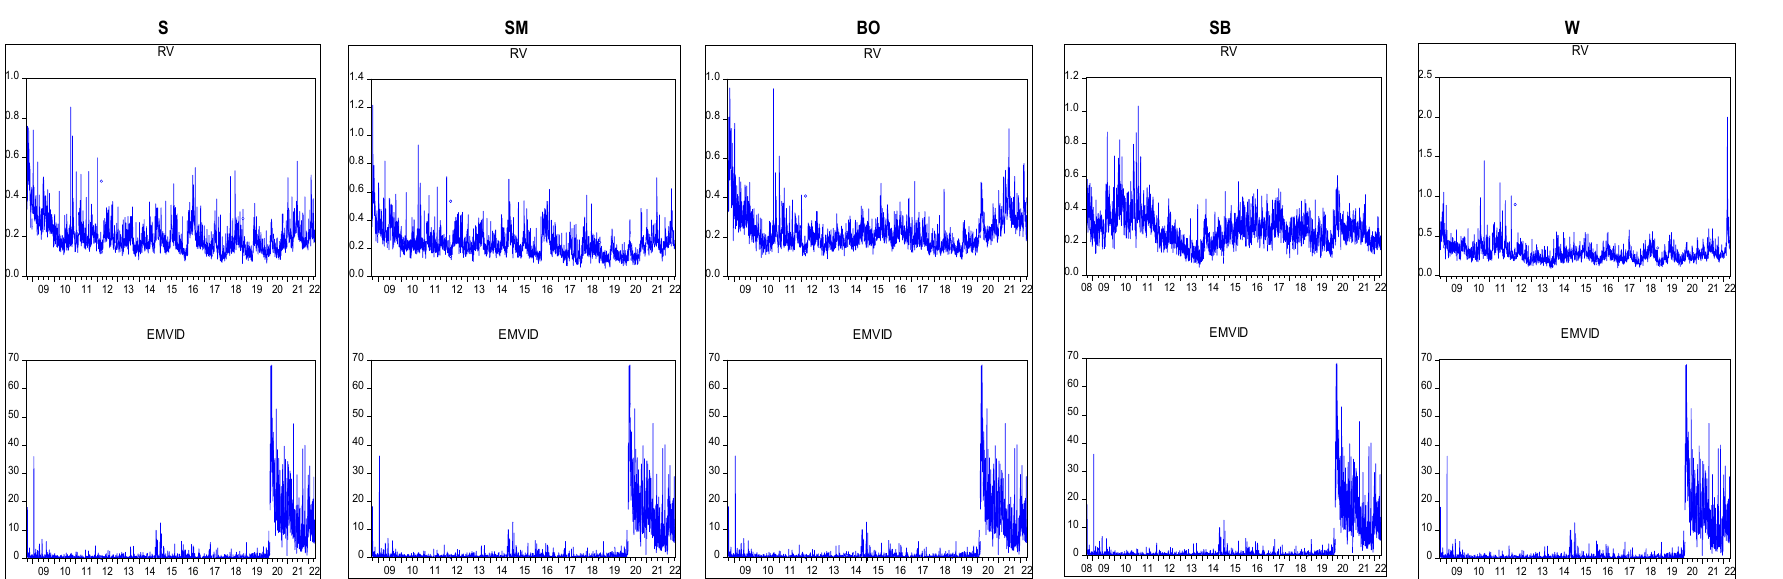
Figure A1. Data plots. Notes: The realised volatility of the agricultural commodity futures is represented by RV. The newspaper-based uncertainty index related to infectious disease is represented by EMVID.